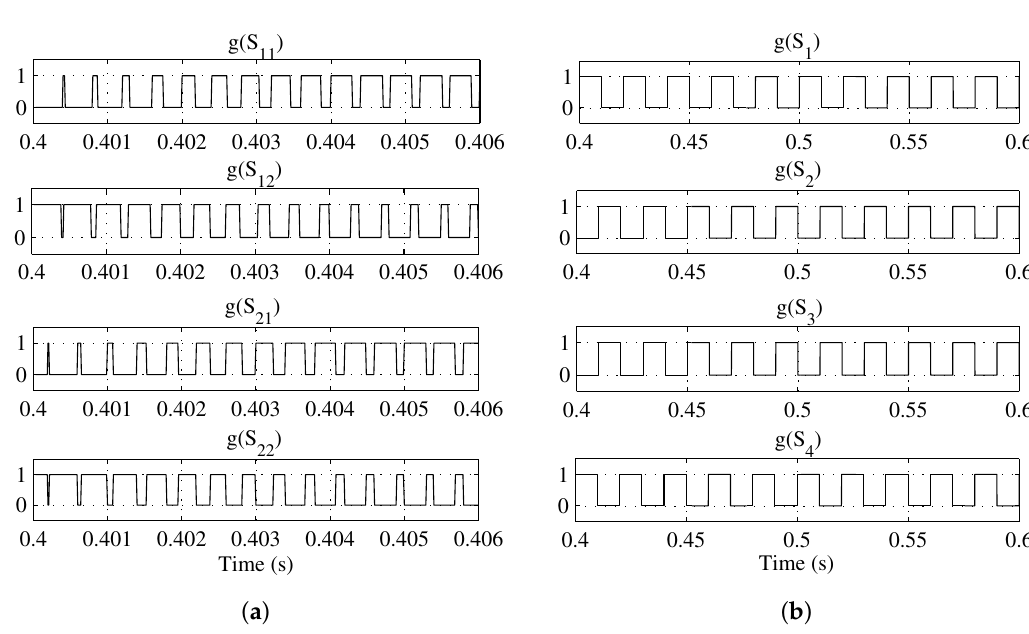
Figure 5. Gate signals of the five-level simulation prototype. ( a ) The gates of the first stage; and ( b ) The gates of the second